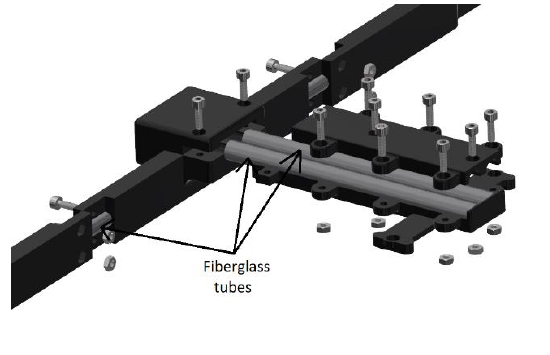
Table 1. Model and range of each sensor